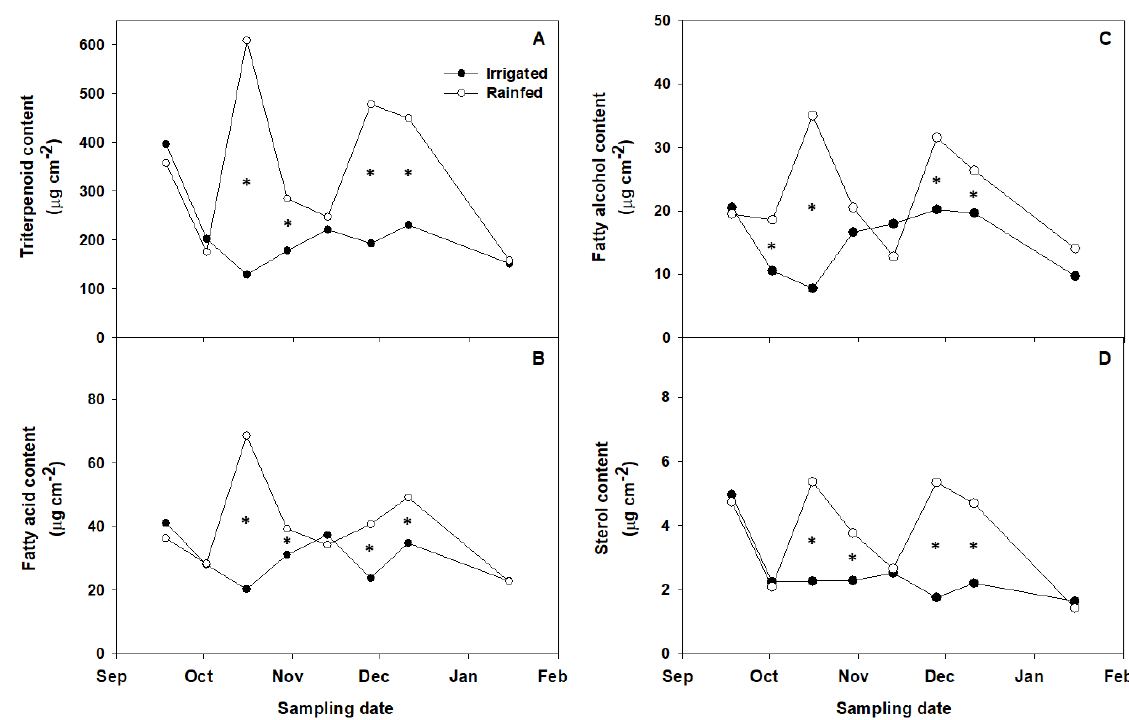
Figure 2. Total triterpene ( A ), fatty acid ( B ), fatty alcohol ( C ), and sterol ( D ) amounts in cuticular waxes of fruit cuticles isolated during ripening of irrigated and non-irrigated ‘Arbequina’ olives. Values represent means of three replicates. Asterisks stand for significant differences between irrigated and non-irrigated trees at p ≤ 0.05 (LSD test).